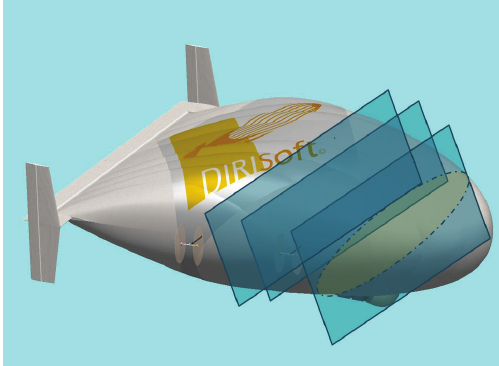
Figure 3: Transverse sections of the